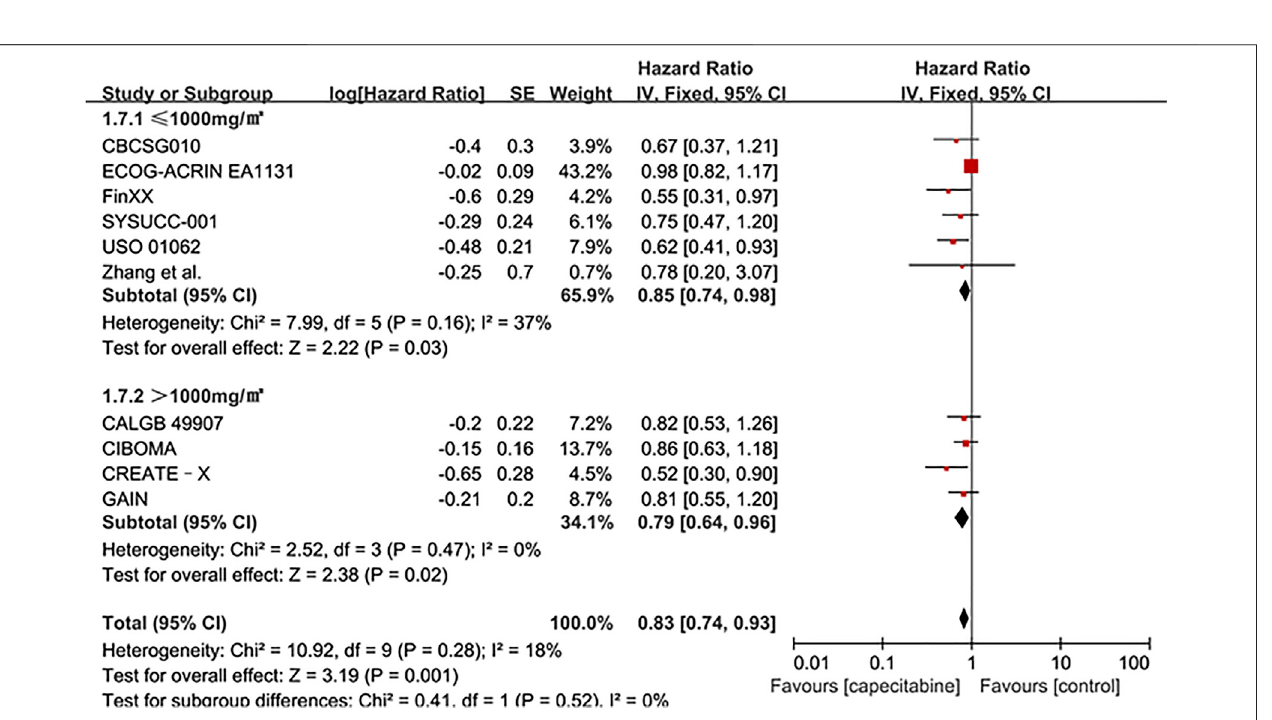
Frontiers in Pharmacology |